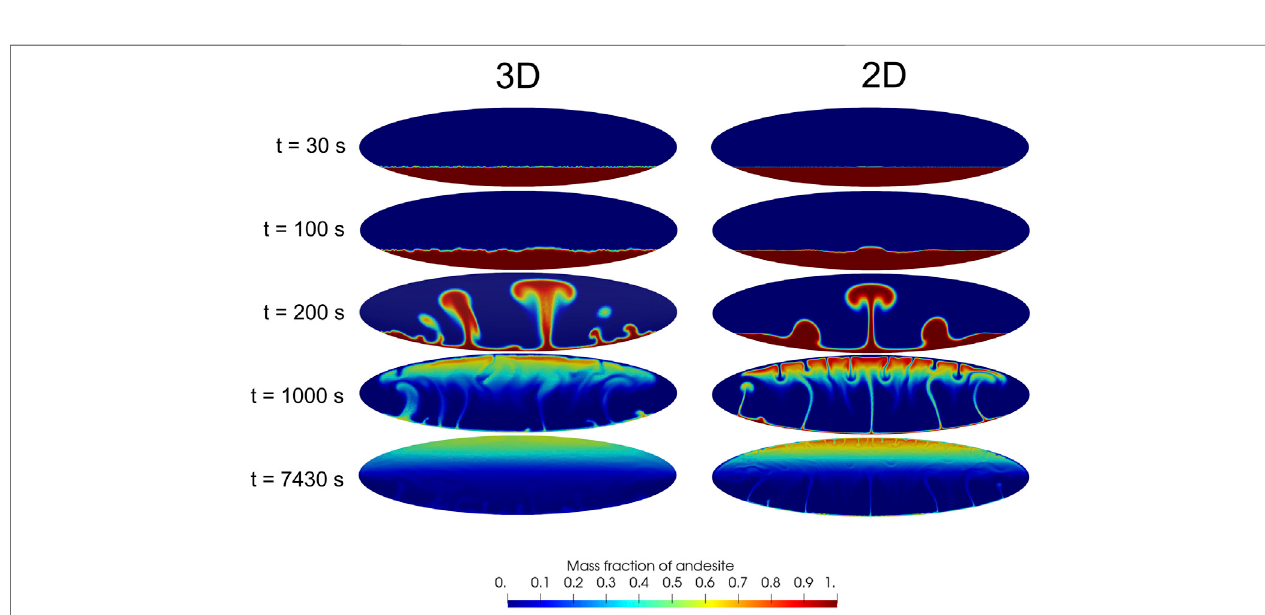
FIGURE 9 | Comparison between 2D simulation and a vertical slice at z (cid:2) 0 from the 3D simulation #3.